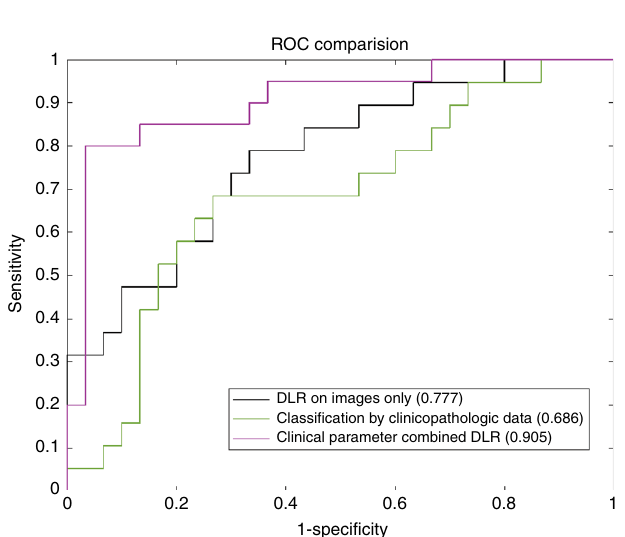
Fig. 4 The confusion matrix of predicting metastasis among disease-free axilla (N0), low metastatic burden of axillary disease (N + (1 – 2)) and heavy metastatic burden of axillary disease (N + ( ≥ 3)). Source data are provided as a Source Data fi